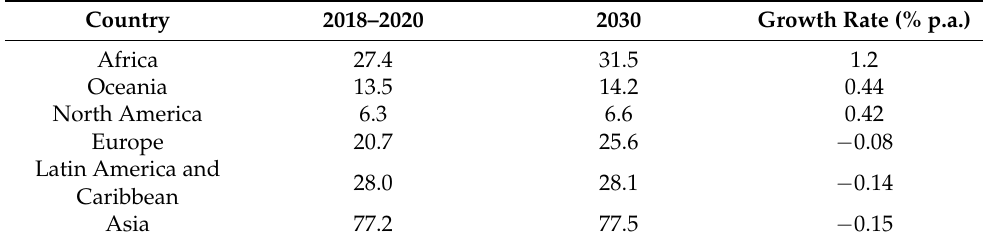
Table 1. Rice per capita consumption (kg/person/year) [5].